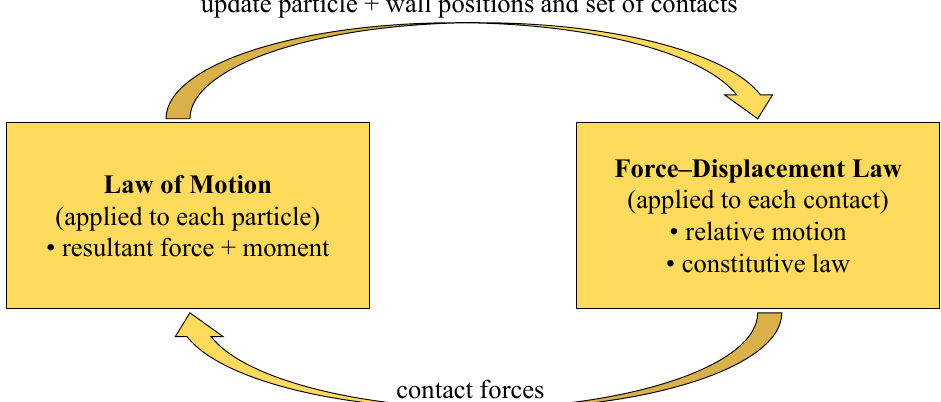
Figure 2. Calculation cycle in PFC2D (modified based on [85]).